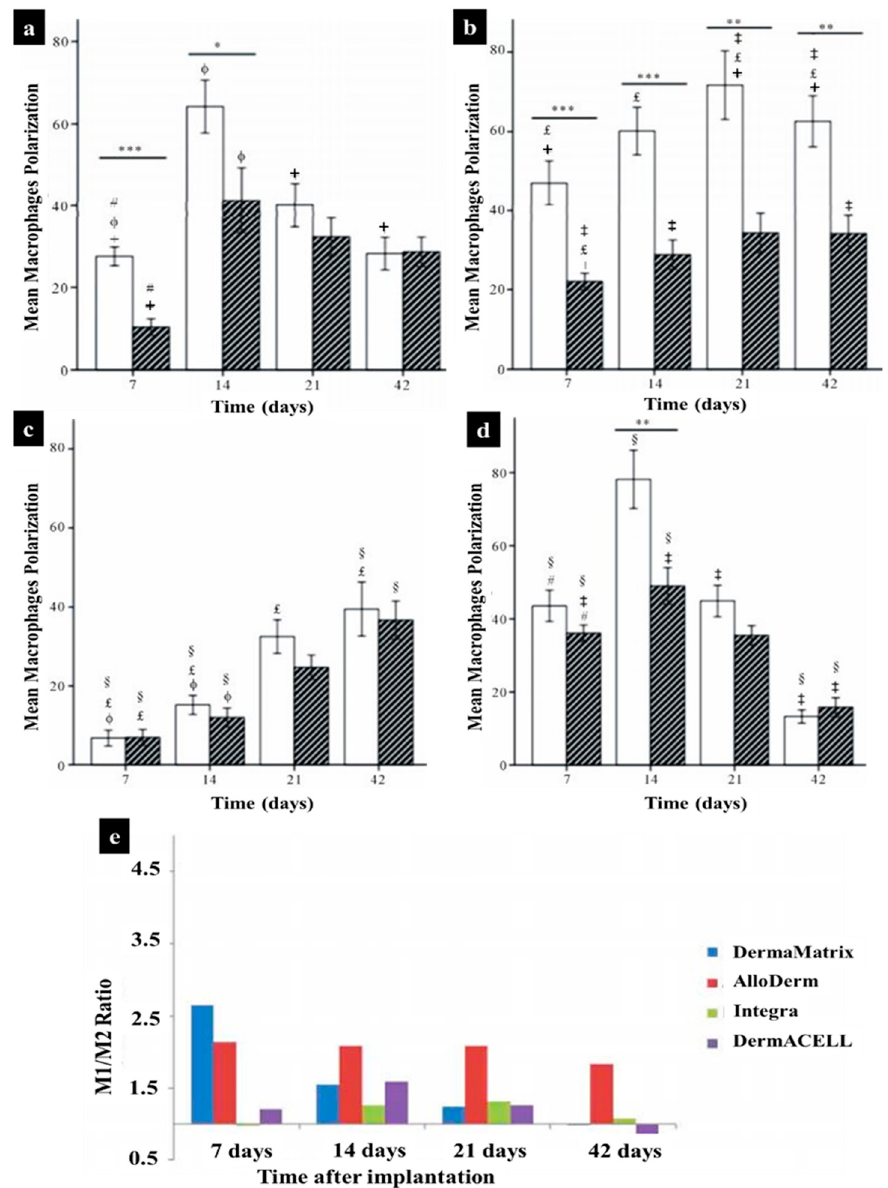
Figure 8. Statistics showing the mean macrophage polarization after implantation of DermaMatrix ( a ), AlloDerm ( b ), Integra ( c ), DermACELL, and ( d ) in adult rats. M1 phenotype represented by white bars and M2 with hatched bars. Comparison between M1 and M2 phenotype at each timepoint; * p < 0.05, ** p < 0.01, *** p < 0.001. ( e ) The ratios of M1:M2 macrophages for dermal matrices at each timepoint (+ DermaMatrix ® vs. AlloDerm ® , Φ DermaMatrix ® vs. Integra ® , # DermaMatrix ® vs. DermACELL ® , £ AlloDerm ® vs. Integra ® , ‡ AlloDerm ® vs. DermACELL ® , § Integra ® vs. DermACELL ® ) [294].